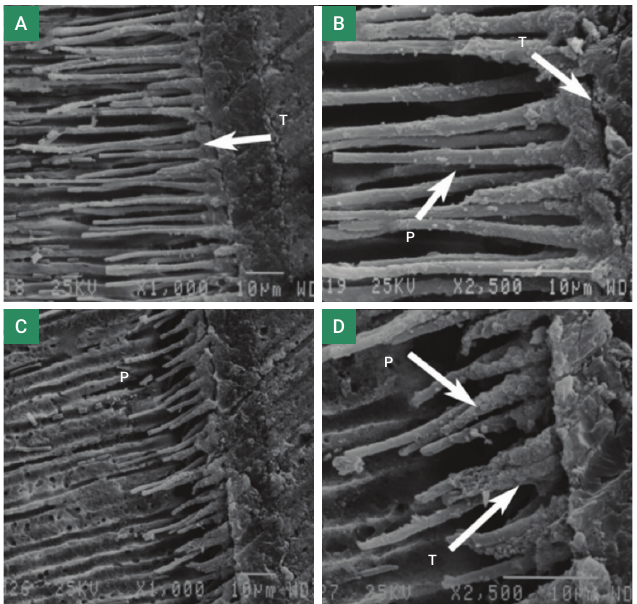
Figure 3. Selected SEM micrographs of resin-dentin interface after the application of bromelain; (A) Single Bond at x1000 magnification; (B) Single Bond at x2500 magnification; (C) OptiBond at x1000 magnification; (D) OptiBond at x2500 magnification. Hybrid layer in this group was thicker than that in the other two groups. The resin tags were thicker and conical in shape (T). Spherical residues were seen on resin tags, which are probably formed by slight penetration of resin into accessory canals in dentin